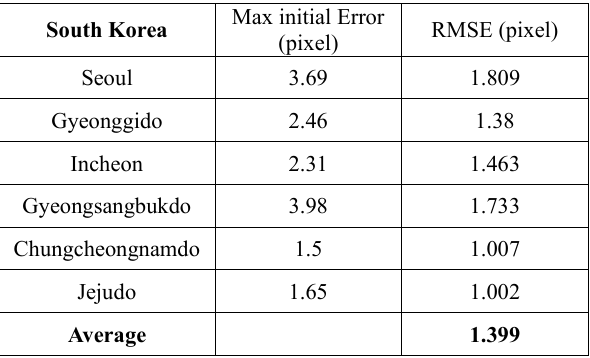
Table 4. Model point geolocation accuracy of precise sensor model (South Korea).